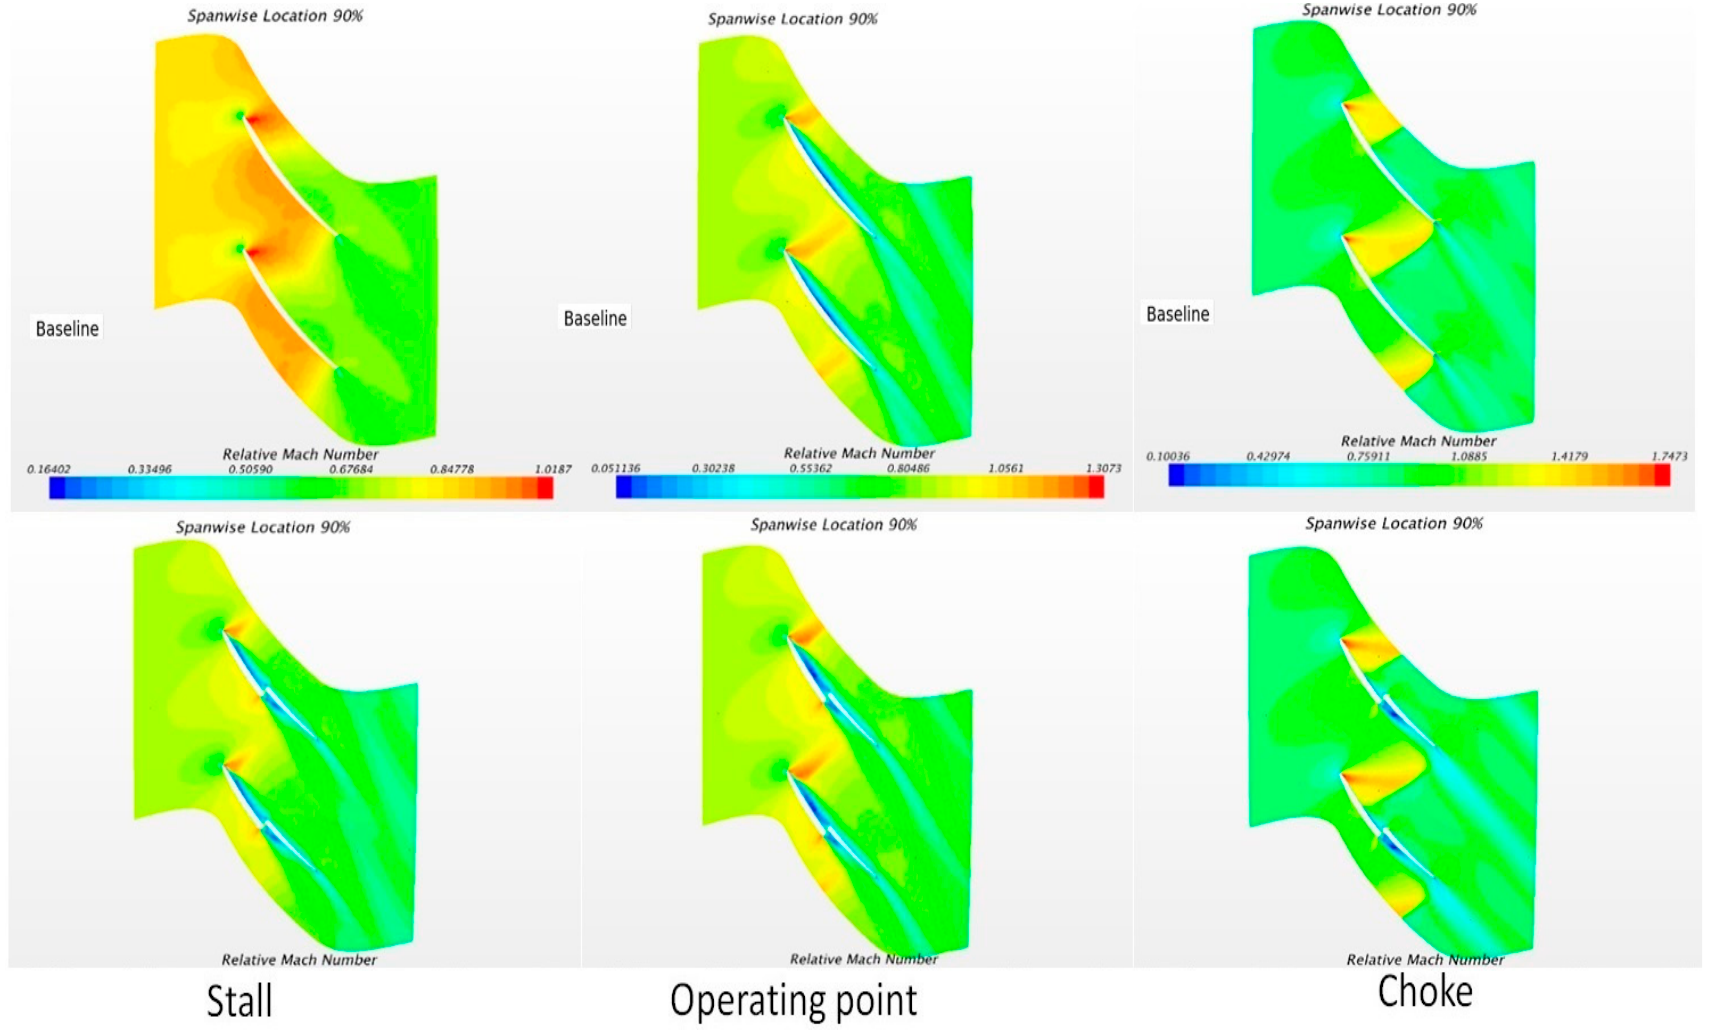
Figure 23. Mrel at 90% span for both rotors at stall, operating point, and choke at 5% tip clearance.